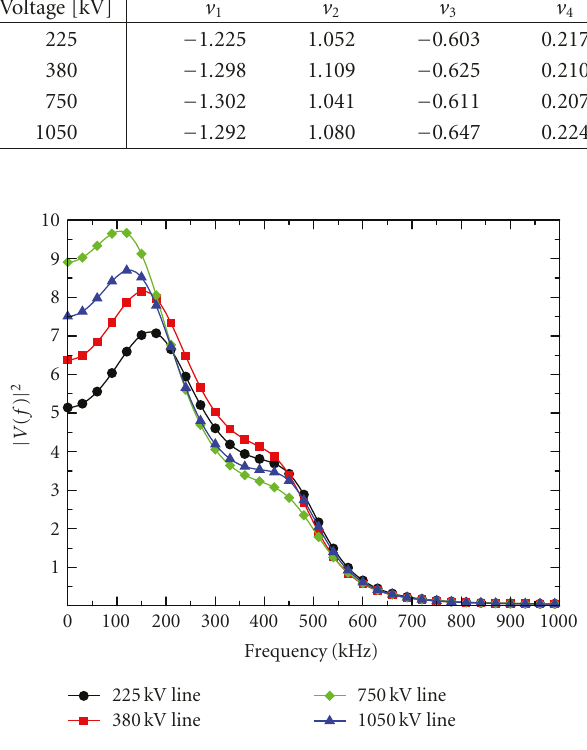
Figure 4: Corona noise power spectrum, shown in terms of the fre- quency response V ( f ) of the AR filter in